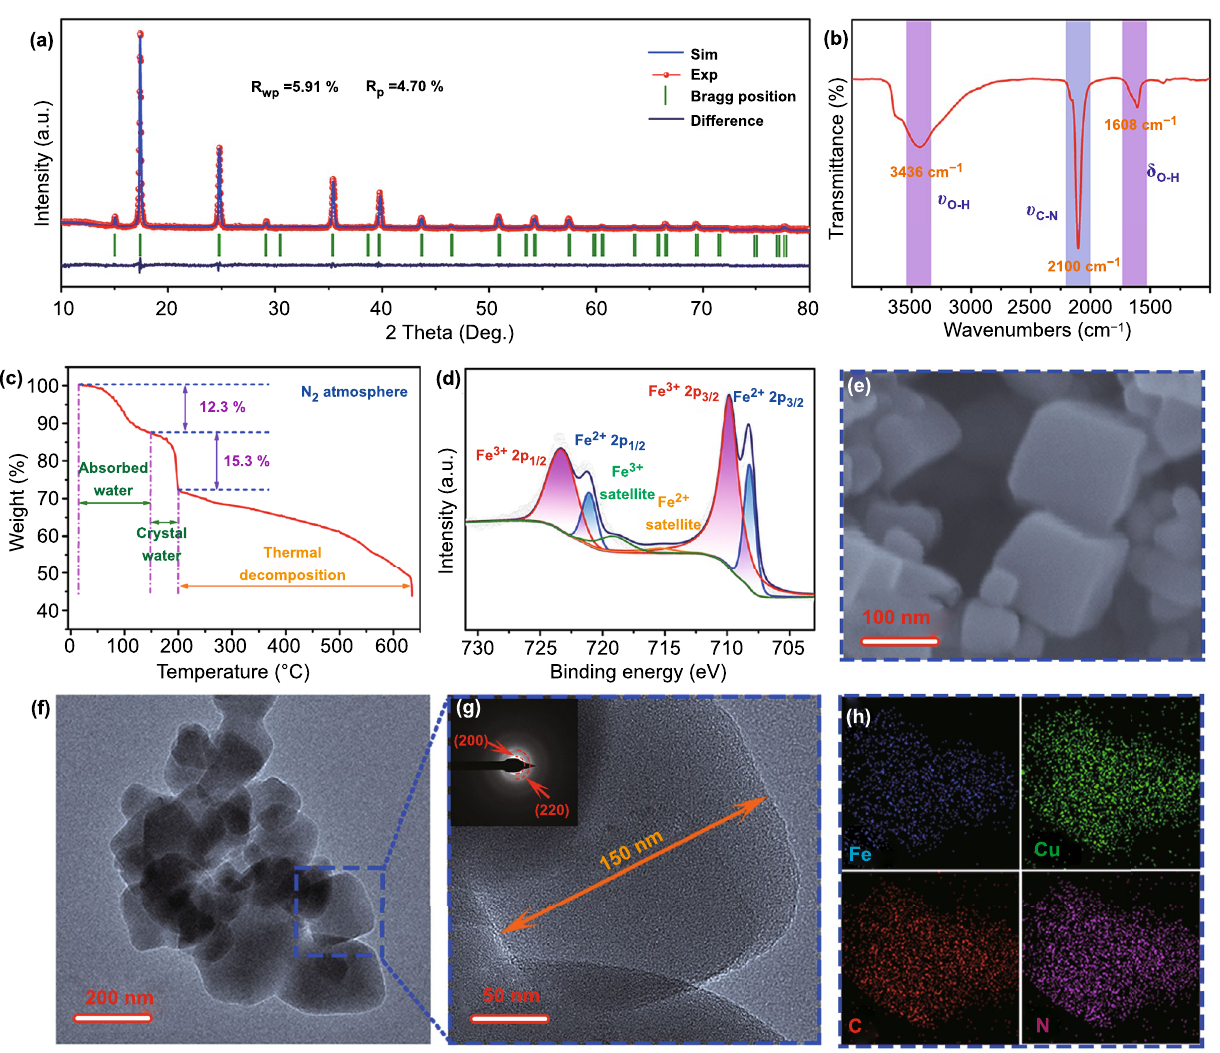
Fig. 2 a Rietveld XRD pattern. b FTIR spectrum. c TGA curve from room temperature to 650 °C at a heating rate of 10 °C min −1 in N 2 atmos- phere. d XPS spectrum of Fe 2p region. e SEM image. f‑g TEM images; the inset is the SAED image. h EDS mapping